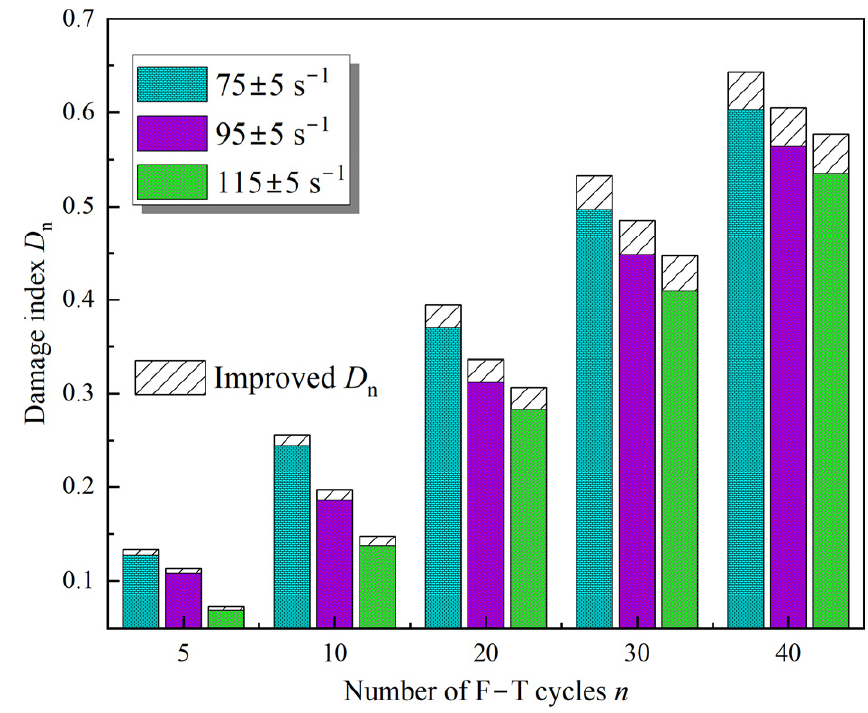
Figure 16. Variation of damage index D n with different F–T cycles.